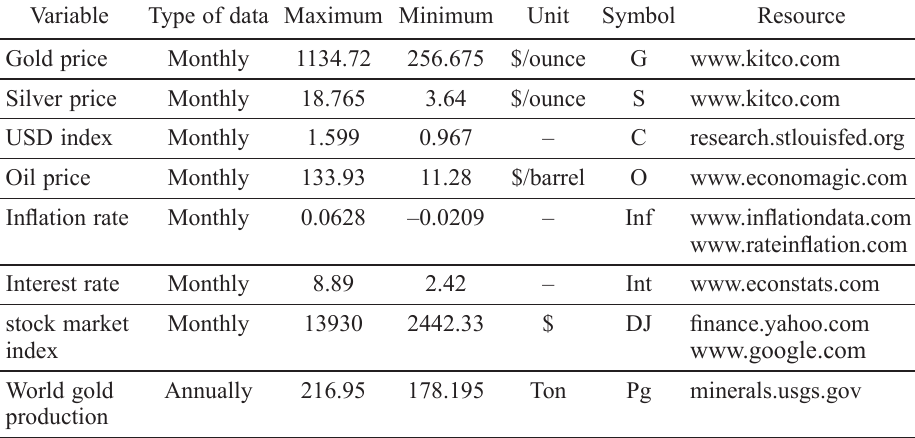
Table 1. Statistical parameters of each data